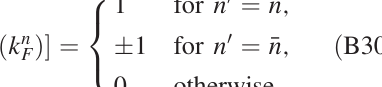
FIG. 13. Phase factor ϑ